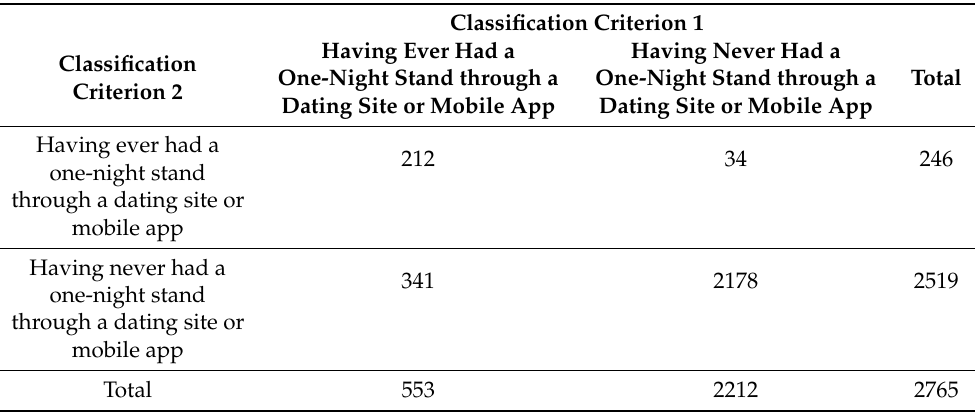
Table 4. Comparison of results of predicting respondents to have ever had a one-night stand through a dating site or mobile app based on classification criterion 1 in (17) and (18) and criterion 2 in